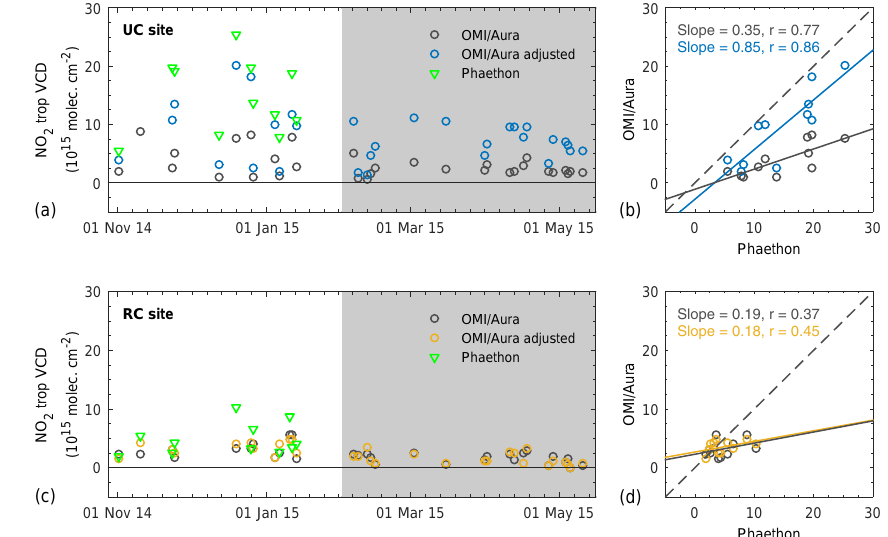
Figure 11. Time series of tropospheric NO 2 over the UC and RC sites derived from Phaethon and OMI before and after the adjustment of OMI data (a, c) . From the measurements at the UC site, only those performed for the period from 1 November 2014 to 31 January 2015 are shown. The corresponding scatterplots are shown in (b, d) . Table 6. Average and standard deviation of the CAMx-simulated NO 2 tropospheric VCDs at the 2km × 2km cell containing each monitoring site and for the OMI nadir pixel (14km × 26km) centered at each site for the entire period of the campaign, separately for all simulations and for simulations near the OMI overpass time. The corresponding mean adjustment factors (AF) for two and three model cells in the light path direction are also